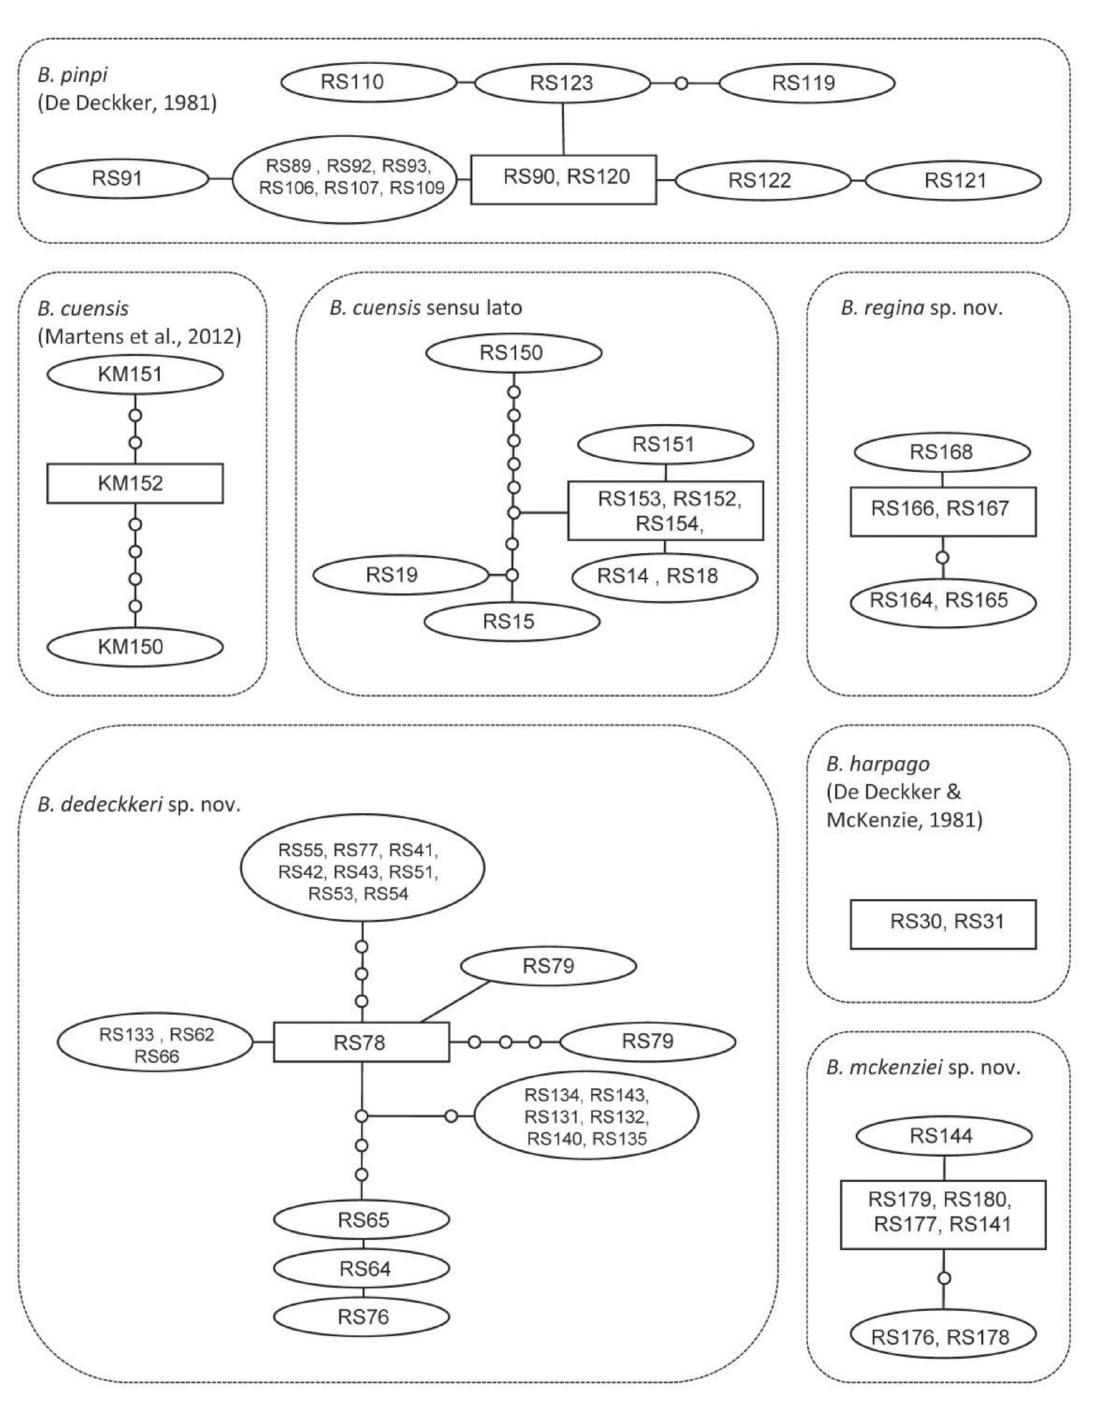
Fig. 3. Parsimonious network constructed at the 95% probability limit with COI sequences from Bennelongia specimens. For each haplotype, sequence names are given. Squares indicate ancestral haplotypes, small circles missing haplotypes and dotted lines connection boundaries. Only seven of the 12 unconnected networks are shown here, the remaining five were clearly separated from the sequences investigated here and corresponded to the published networks in Martens et al . (2012). Six of the unconnected networks shown here are congruent with the newly described species. One network with previously published sequences ( B. cuensis Martens et al ., 2012) was included to illustrate its separation to the cryptic species B. cuensis sensu lato